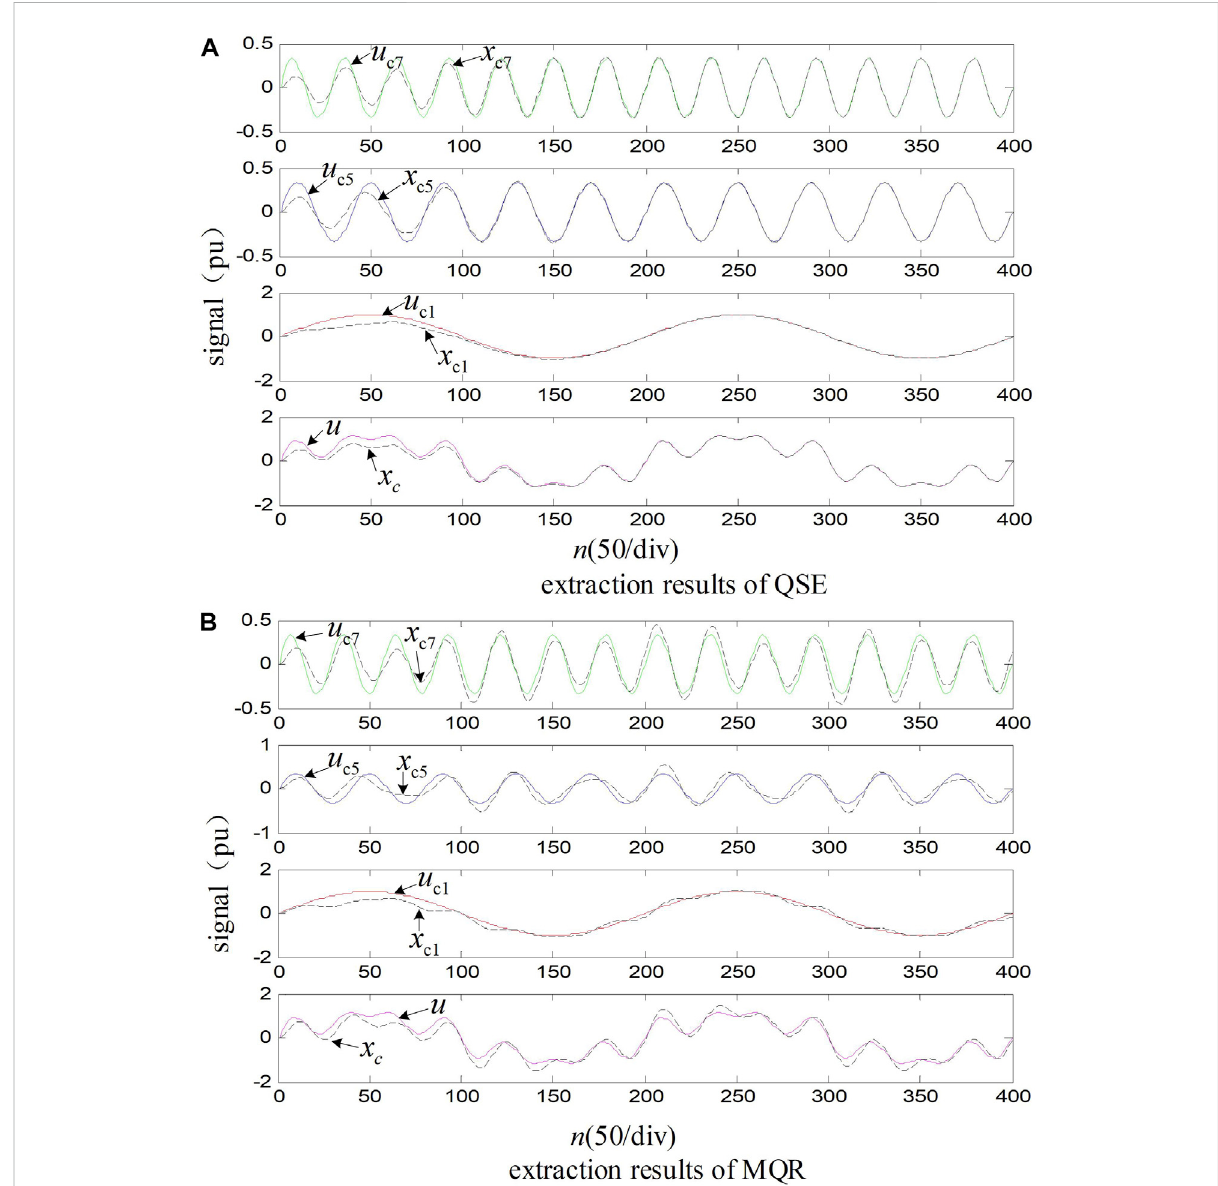
FIGURE 4 Comparation of extraction results of QSE and MQR, “ signal ” is the signal to be extracted and “ n ” is the sampling period.